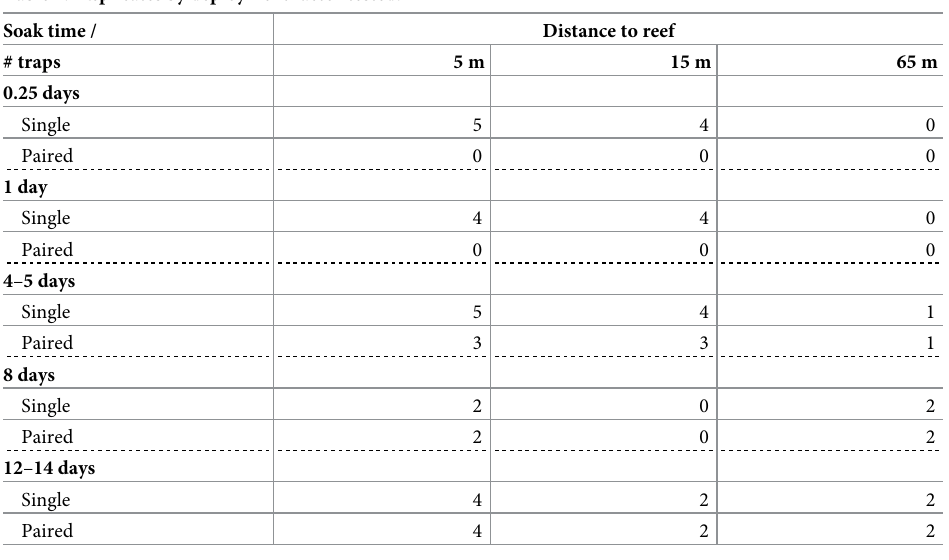
Generalized linear mixed models (GLMMs) were computed to test the effect of deployment factors (i.e., number of traps, distance to artificial reef, and soak time) on 1) lionfish recruit- ment, 2) lionfish catch, 3) native fish recruitment, and 4) native fish catch ( Eq 1). Lionfish den- sity on the adjacent artificial reef site was included as a covariate. Individual artificial reef sites were sampled multiple times with different deployment configurations and soak times, thus the reef site was included in the GLMMs as a random effect (random intercept) and assumed to be normally distributed with a mean of zero and variance σ 2 . Deployment factors and the lionfish density covariate were evaluated at an experiment-wise error rate ( α ) of 0.05. Quan- tile-quantile (QQ) plots were used to determine if errors were best fit with a normal, lognor- mal, Poisson, or negative binomial distribution. Likelihood was estimated with Laplace approximation based on GLMM fitting and inference protocols [48]. Analyses were conducted in R (version 3.6.1) using the LME4 [49] and MASS [50] packages. See supplemental material for R code and raw data. The QQ plots can be produced by running the R code.